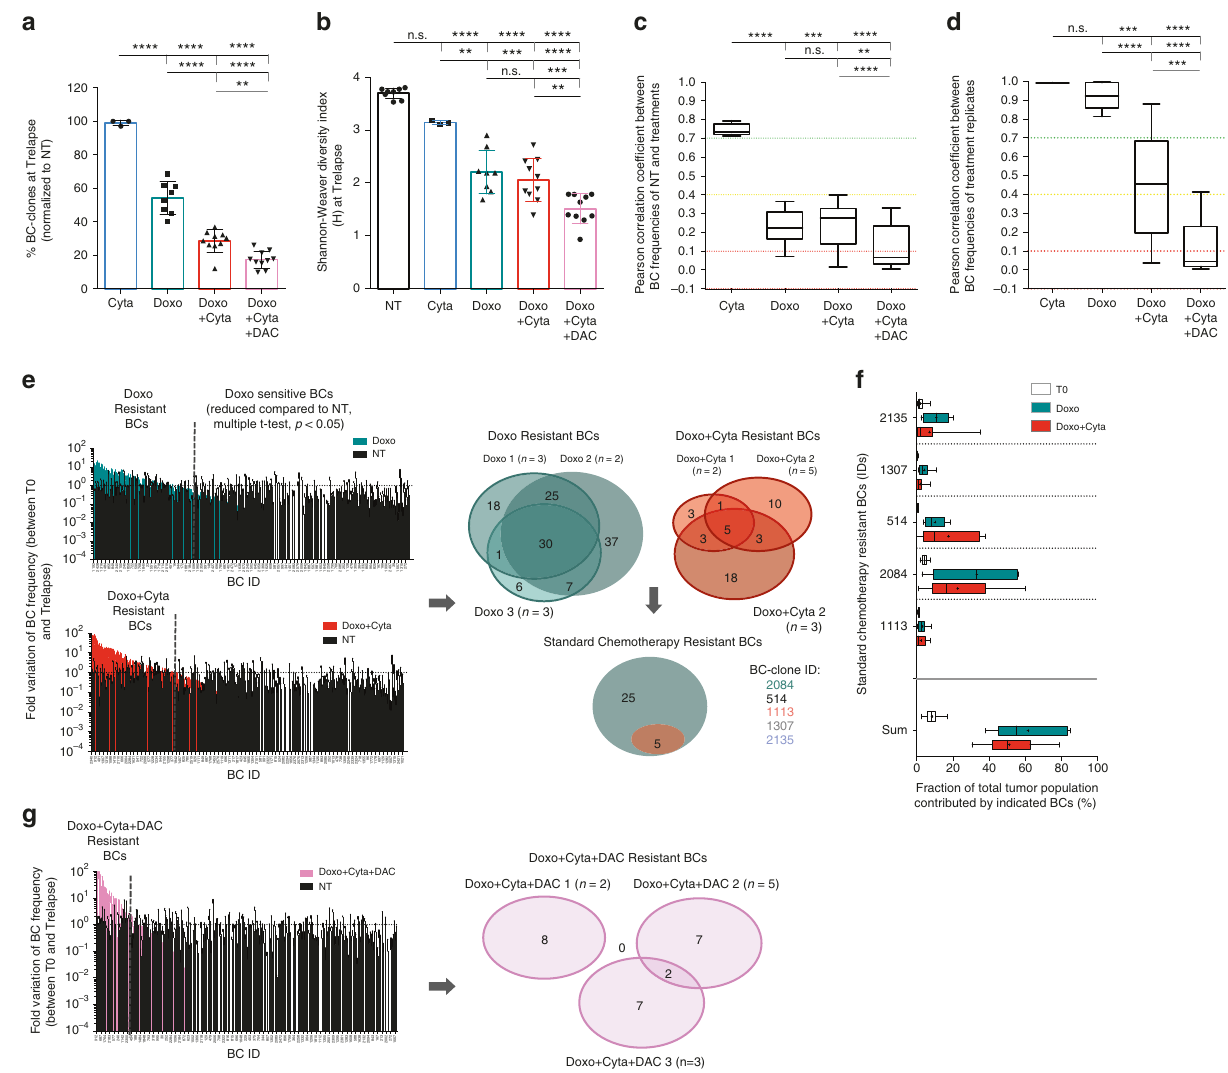
Fig. 2 Pre-determined set of BC-clones associates with chemoresistant relapses. (Data relative to HEL cell line) a Normalized (to NT) frequency of barcodes detected at Trelapse in Cyta ( n = 3), Doxo ( n = 8), Doxo + Cyta ( n = 10) and Doxo + Cyta + DAC ( n = 10) groups. b Shannon-Weaver diversity index ( H ) of indicated Trelapse groups. H = − Sum( xi LN xi ), where xi is the frequency of each BC-clone in the population. H re fl ects the BC number and how evenly distributed these are in the population (higher H results from higher BC number and more even distribution). c Pearson correlation coef fi cient between BC-clonal architectures of each treatment and NT groups (Cyta: n = 9, Doxo: n = 19, Doxo + Cyta± DAC = 36). d Pearson correlation coef fi cient between BC-clonal architectures of replicates within each treatment group at Trelapse.(Cyta: n = 3, Doxo: n = 10, Doxo + Cyta ± DAC = 14) e Strategy used to de fi ne Doxo and Doxo + Cyta resistant BC-clones. On the left are depicted the fold variations of each BC-clone between T0 and Trelapse in Doxo and Doxo + Cyta groups compared to NT, chemoresistant BC-clones were de fi ned has the ones showing equal or increased fold variation relative to NT, determined by preforming multiple t -testing (per individual BC, P < 0.05). This was performed in three independent experiments ( n = 2, n = 5, n = 3). On the right, venn diagrams depicting the overlap of chemoresistant BC-clones, shared between all the replicates of three independent experiments for Doxo and Doxo + Cyta groups; as well as the overlap between these respective cores. The list of the chemoresistant BC-clones is indicated with respective BC- identi fi cation (id). f Average frequency of each indicated BC-clone (and their summed frequency) in Doxo ( n = 8), Doxo + Cyta ( n = 10) at Trelapse and T0 ( n = 5). Boxplots c , d and f : center line is median, lower box bound is the 25% percentile, upper box bound is the 75% percentile, whiskers are minimum and maximum values. Cross is the mean ( f ). g Same as e but applied to Doxo + Cyta + DAC group. Graphs of mean ± s.d., P values were determined by one-way ANOVA test. ns – not signi fi cant, * P < 0.05; ** P < 0.01; *** P < 0.001; **** P < 0.0001. Source data are provided as a Source Data fi